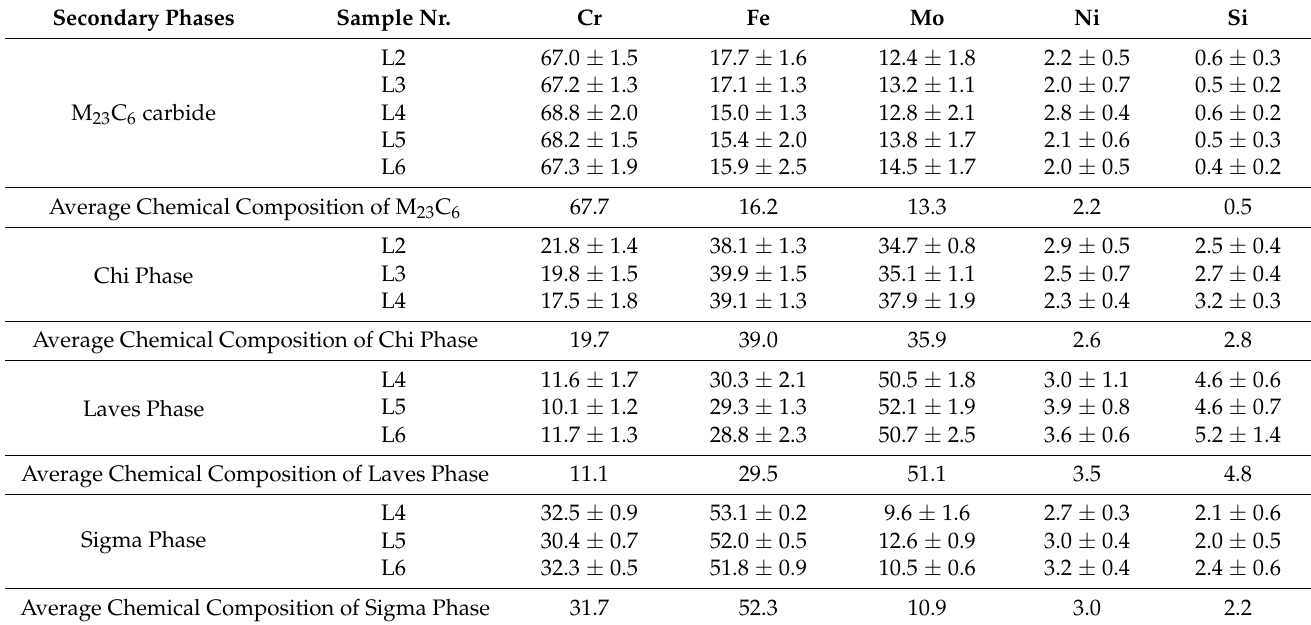
Table 3. Chemical compositions of identified secondary phases in AISI 316L (0% CW) with conditions provided in Table